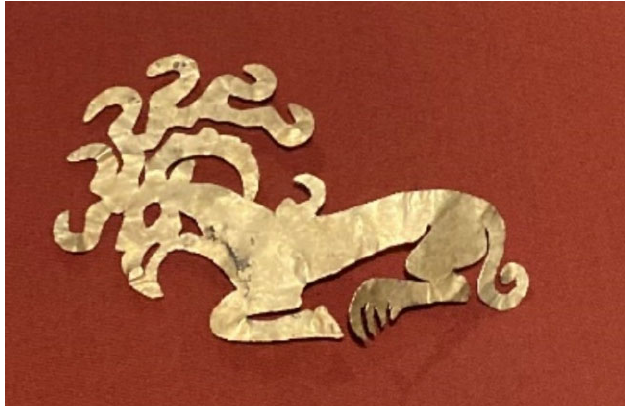
Figure 18. ‘ Hippogriff’ (EKRM inv. no. K П O94 ‐ 39409 ‐ 39413); gold; Kurgan 7, Group IV, Eleke Sazy,